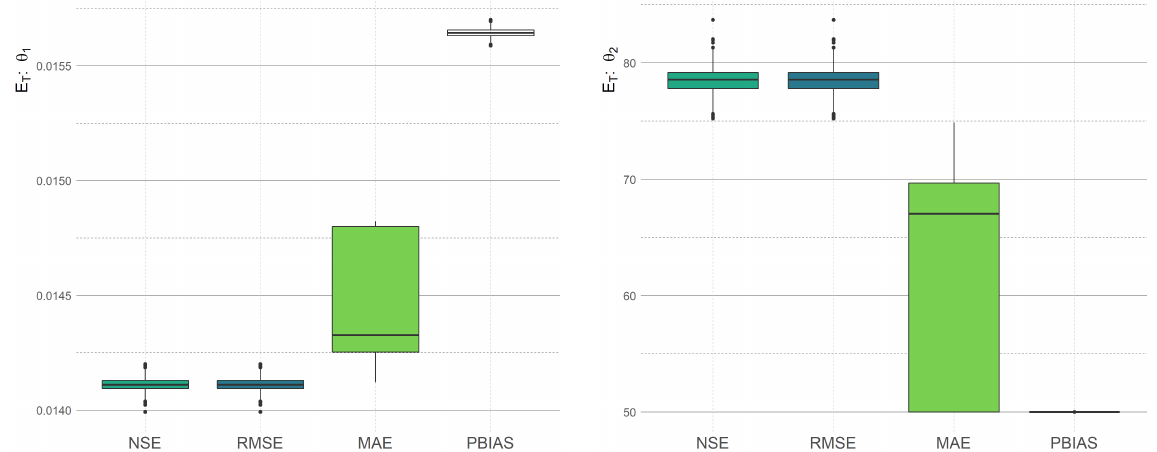
Figure 7. The comparison of the calibrated Turc model parameters obtained by the cross-validation calibration process on training data with respect to various statistical